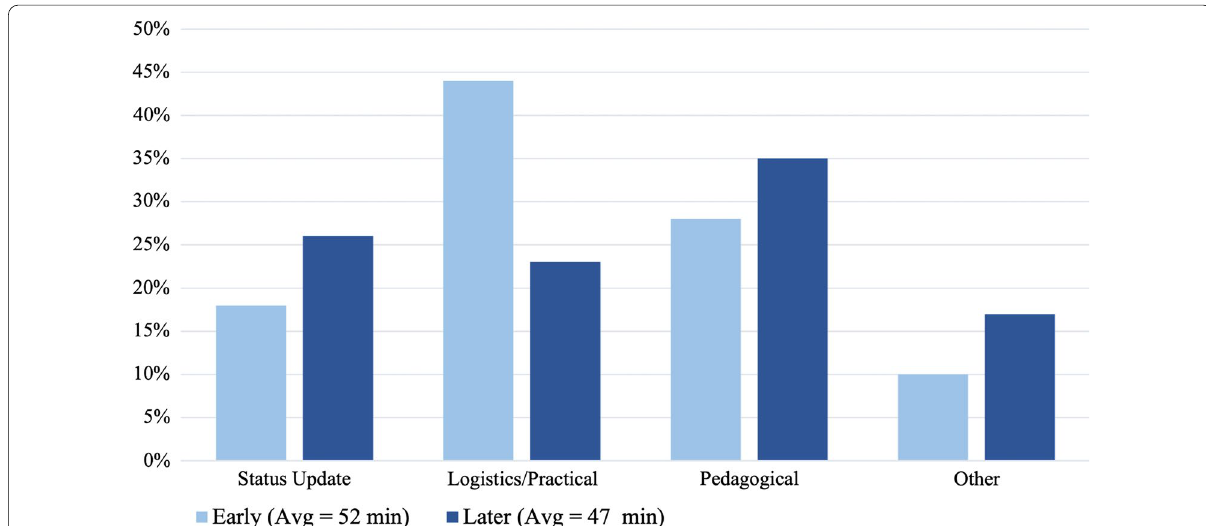
Fig. 9 Duration of conversation coded for each Segment Content Category. Segment content categories coded are coded as relating to status updates, logistical/practical issues, pedagogical issues, or other kinds of discussions (as a percentage of the total T&L talk duration, shown in parentheses) in early versus later